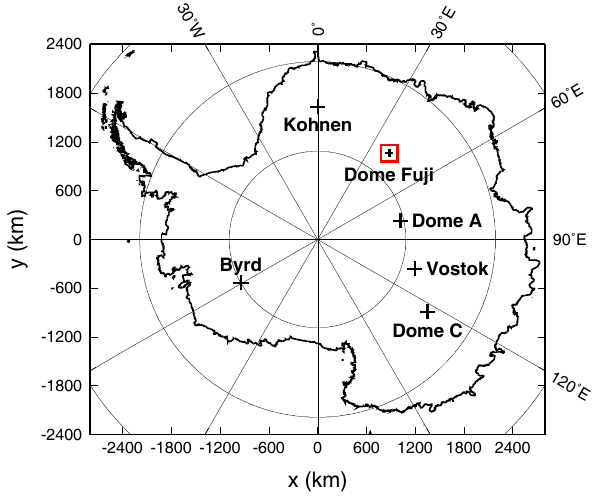
Fig. 1. The Antarctic ice sheet (with ice shelves), and the locations of the drill sites Dome Fuji, Vostok, Dome A, Dome C, Kohnen and Byrd. The red square around Dome Fuji represents the 203 . 092 × 203 . 092km domain which is modelled in this